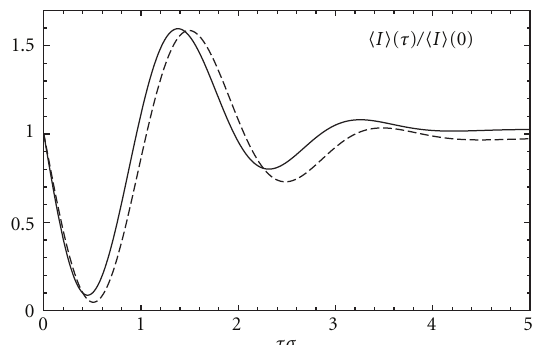
Figure 3: The normalized intensity (cid:4) I (cid:2) ( τ ) / (cid:4) I (cid:2) (0) as a function of the time-delay τσ for the case of coherent states as generated by the same single-photon states as in Figure 2. Two di ff erent examples are plotted with ω s = 3 σ : ω lo = 3 . 15 σ with (solid line) or ω lo = 2 . 85 σ (dashed line). The asymptotic values of (cid:4) I (cid:2) ( τ ) / (cid:4) I (cid:2) (0) are as in Figure